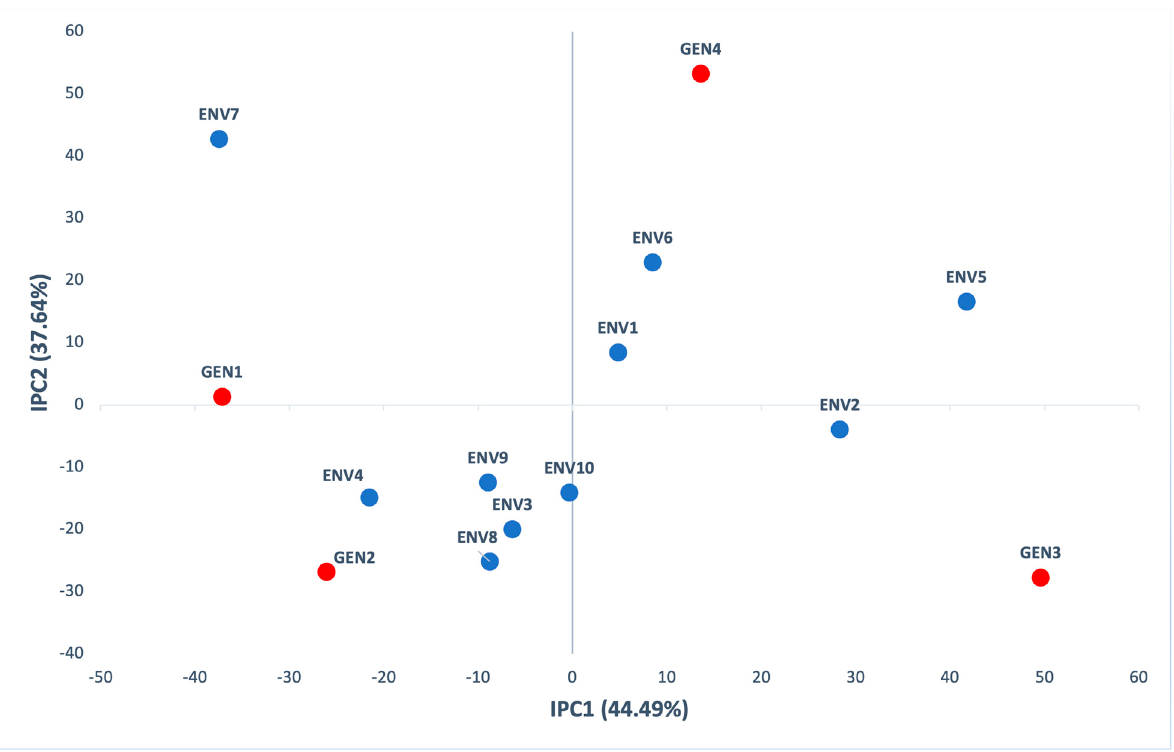
Figure 3. AMMI biplot presenting the second interaction principal components axis (IPC2) against the first interaction principal components axis (IPC1) scores for grain yield (kg/ha) of 4 genotypes (red) evaluated in 10 environments